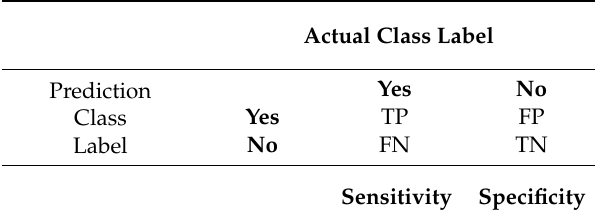
Table 4. Definition of classification metrics.